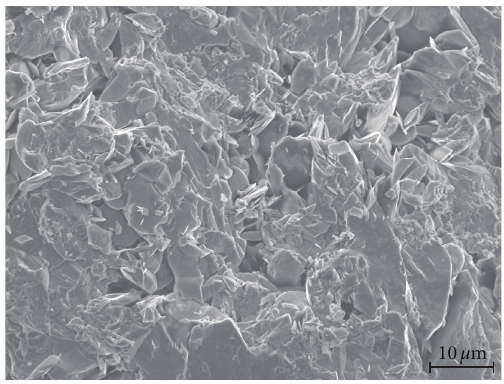
Figure 1: Polycrystalline hematite.